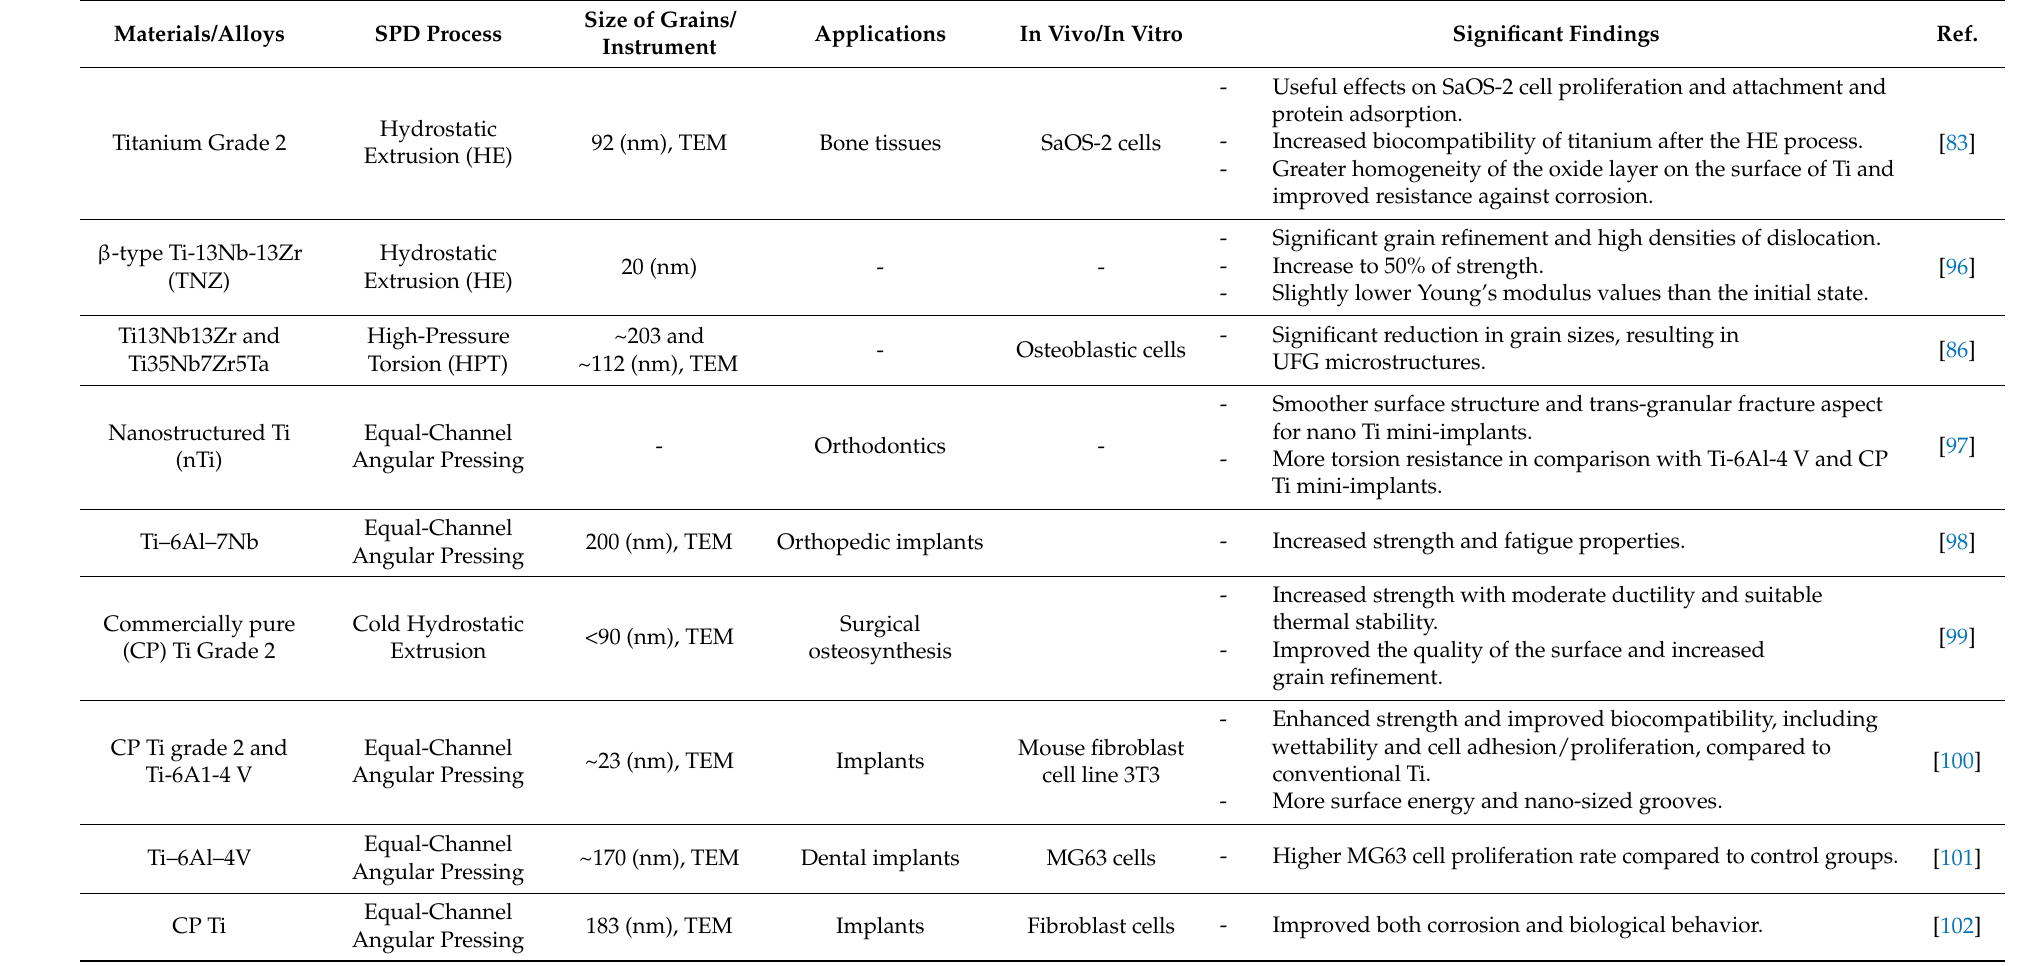
Table 2. Summary of studies on ultra-fine-grained (UFG)/Nano grain NG titanium produced using